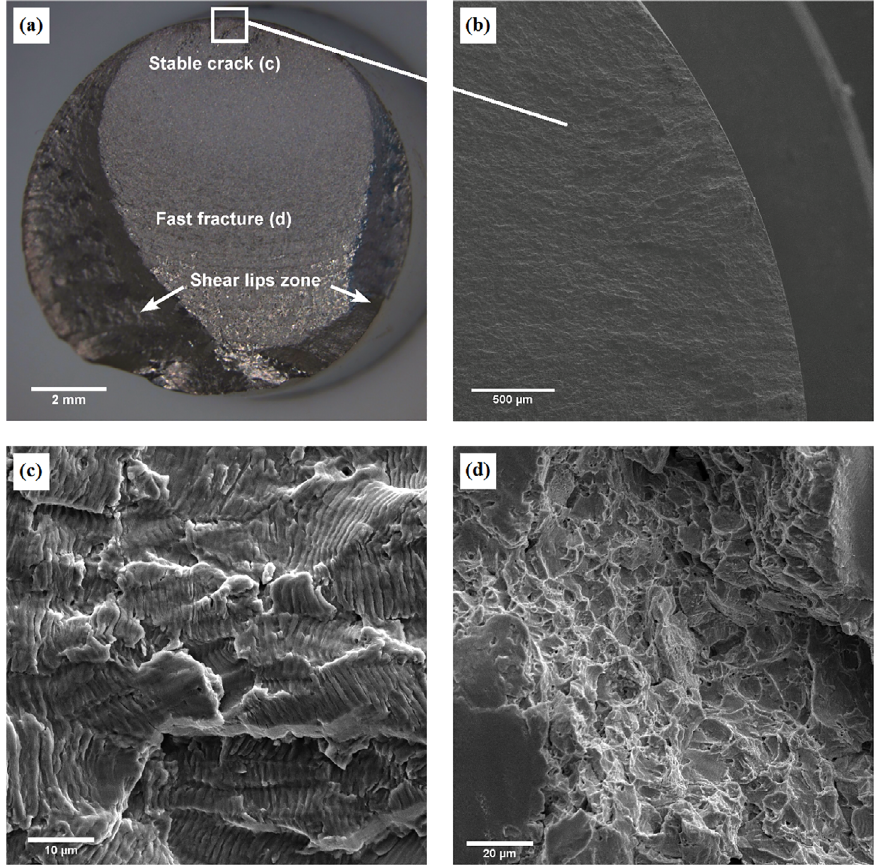
Figure 11 . Inconel 625 fracture surface after failure at 110067 cycles under maximum stress of 472 MPa: (a) appearance of the fracture surface, (b) microscopic crack nucleation region, (c) failure mode in the stable crack growth region, (d) failure mode in the fast fracture